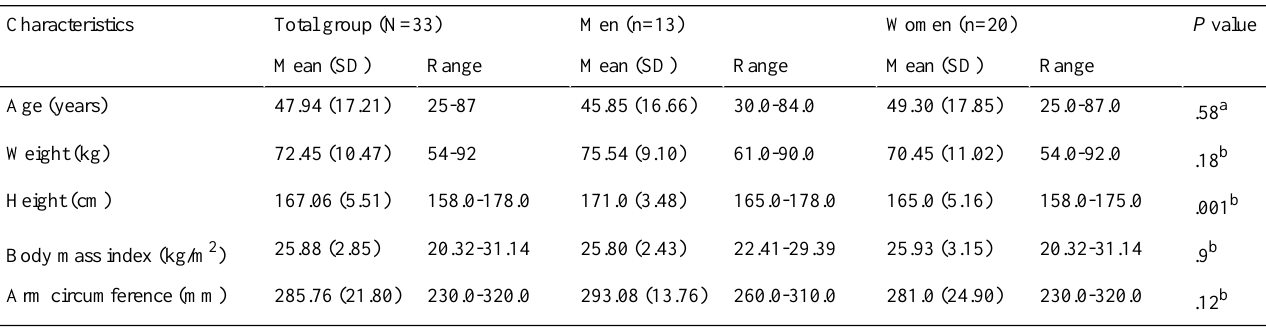
Table 1. Sociodemographics characteristics of the